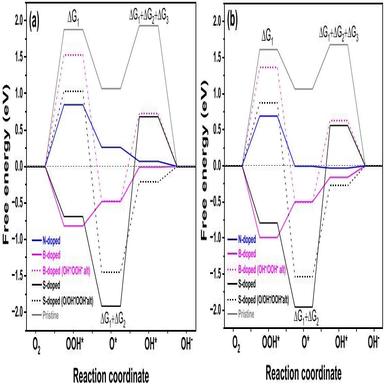
Schematic Gibbs free energy diagrams of ORR for pristine and doped graphene by VASP (a) and VASPSol (b) implicit water solvent model calculations. The solid lines show the lowest energy structures, N-doped in blue, B-doped in magenta, S-doped is shown in black, and pristine graphene in grey. The dashed lines show alternative adsorption sites for the S-doped and B-doped cases.